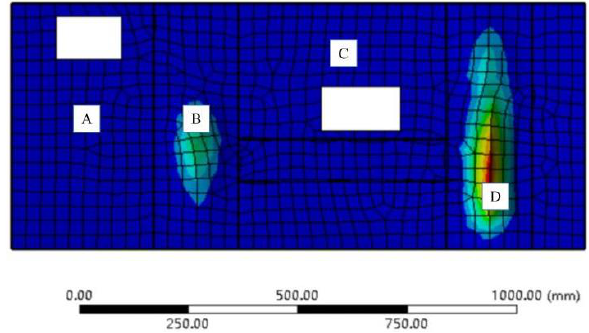
Figure 19. Diagram of simulation dynamic response.